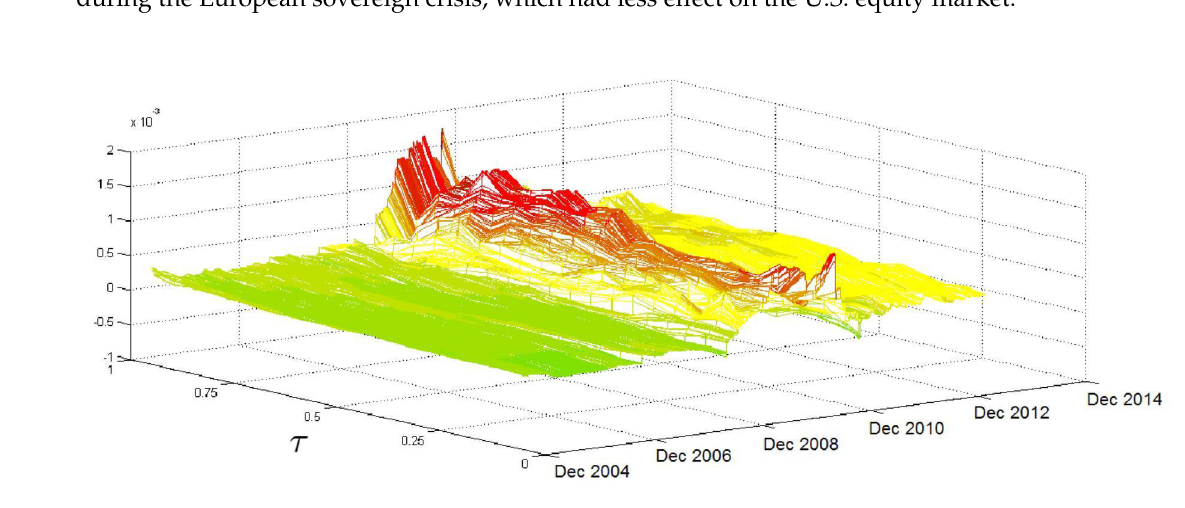
Figure 4. Rolling analysis for vix t − 1 .